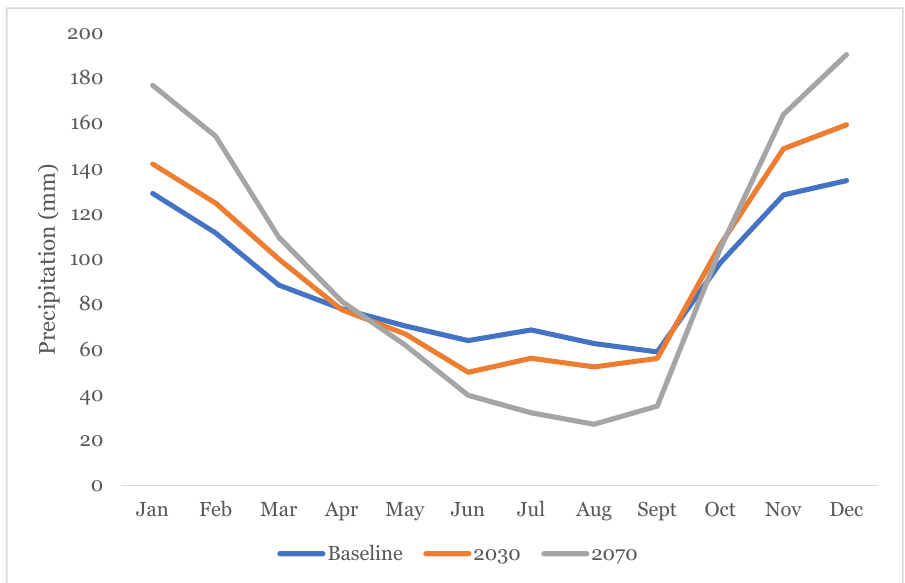
Figure 8. Annual profile of average monthly precipitation in Cardiff for baseline, 2030 and